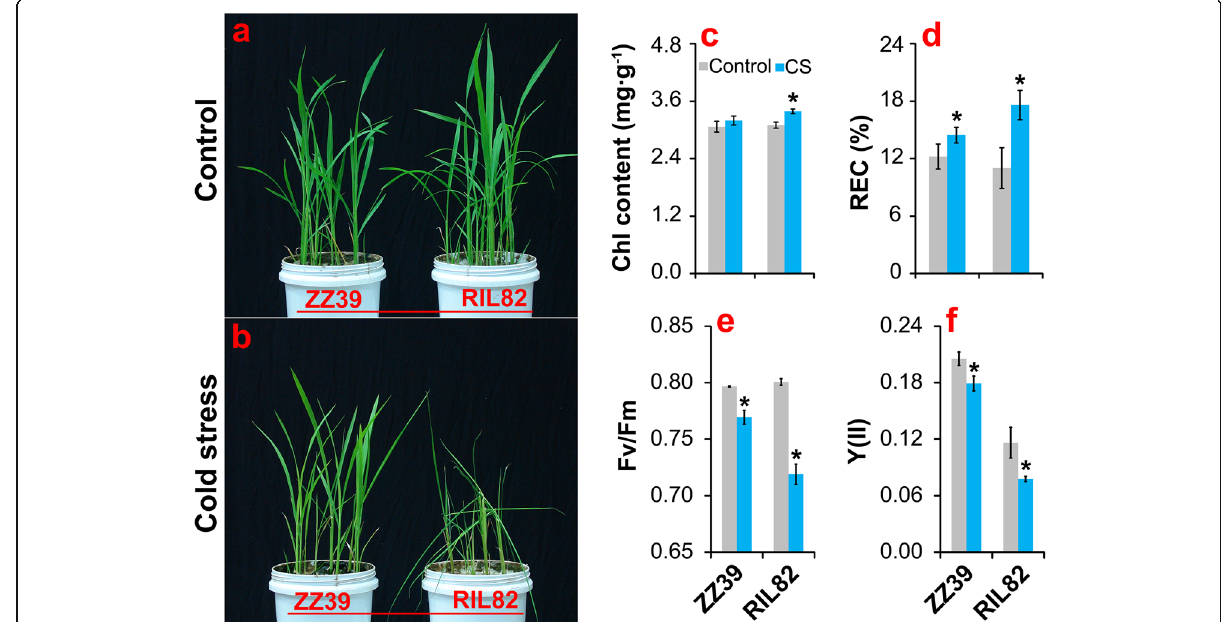
Fig. 1 The response of rice plants to cold stress. a and b , The photograph of ZZ39 and RIL82 plants under control and cold stress conditions, respectively; c , Chlorophyll content; d , REC; e , Fv/Fm; f , Y (II). Chl, Chlrophyll; REC, Relative electrical conductance; Fv/Fm, Maximum fluorescence quantum of PSII; Y (II), Actual fluorescence quantum of PSII. Vertical bars denote standard deviations ( n = 4). A t -test was adopted to compare the difference between control and cold stress within a cultivar. * denotes P <